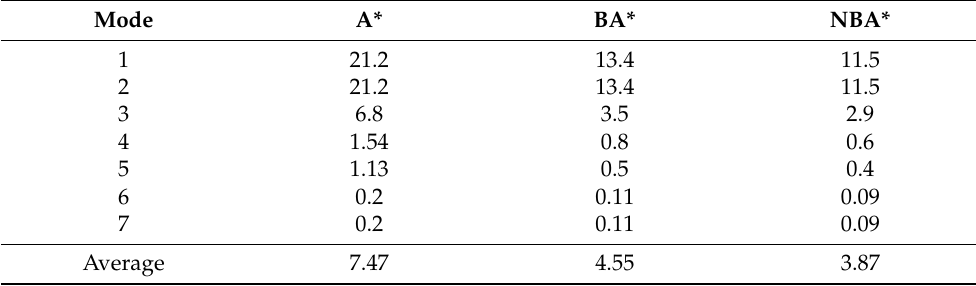
Table 7. Performance comparison of path searching algorithms (second).